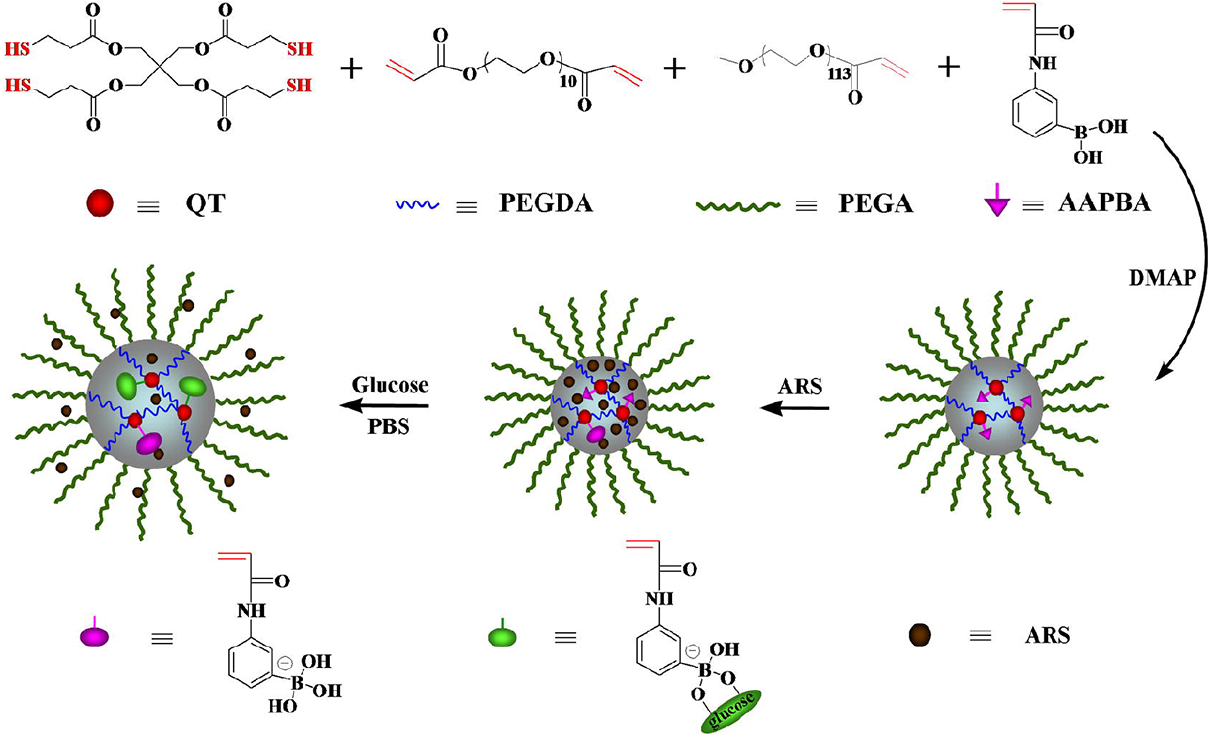
Figure 8: Structures of nanogels and glucose-sensitive behaviors of ARS-loaded nanogels in PBS [44]. Reprinted with permission from